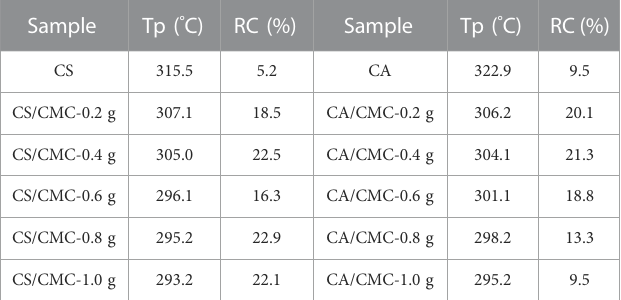
TABLE 1 Temperature of maximum weight loss rate (Tp) and residual carbon rate (RC) of the starch composite fi lms.